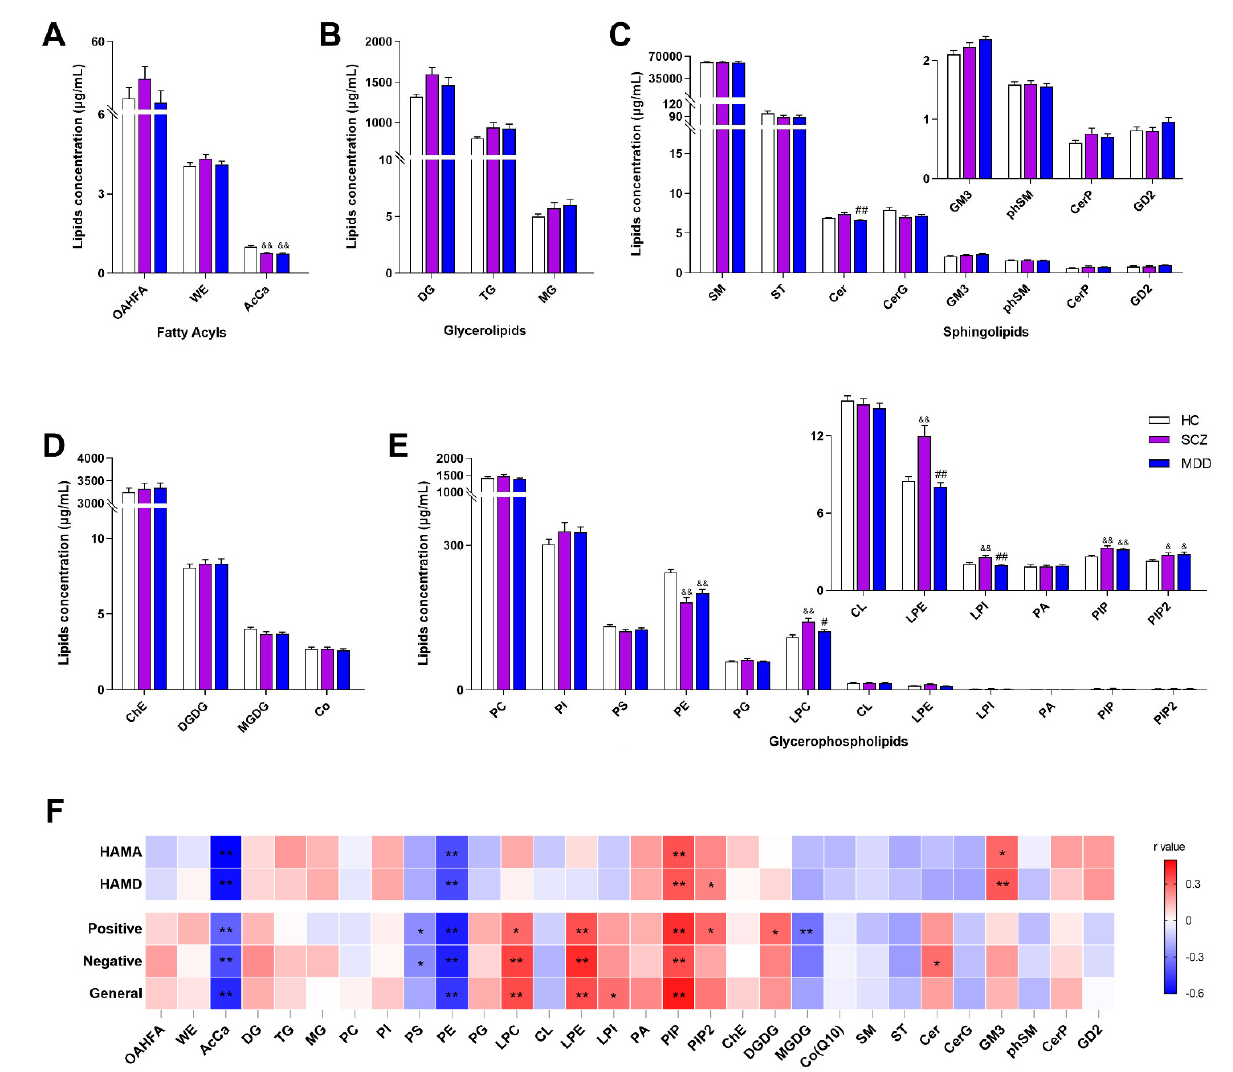
Figure 1. The comparison of lipid class among SCZ, MDD, and HC participants. ( A ) Fatty acyls, ( B ) glycerolipids, ( C ) sphingolipids, ( D ) ChE, Co, DGDG, and MGDG, ( E ) glycerophospholipids, and ( F ) correlation between clinical parameters and levels of lipid classes. AcCa, acylcarnitine; Cer, ceramides; CerG, glucosylceramides; CerP, ceramide phosphate; ChE, cholesterol ester; Co, coenzyme; CL, cardiolipin; DG, diglyceride; DGDG, digalactosyldiacylglycerol; LPC, lysophosphatidylcholine; LPE, lysophosphatidylethanolamine; LPI, lysophosphatidylinositol; MG, monoglyceride; MGDG, monogalactosyldiacylglycerol; OAHFA, (O-acyl)-1-hydroxy fatty acid; PA, phosphatidic acid; PC, phosphatidylcholine; PE, phosphatidylethanolamine; PG, phosphatidylglycerol; PI, phosphatidylinositol; PIP, phosphatidylinositol; PIP2, phosphatidylinositol 4,5-bisphosphate; PS, phosphatidylserine; phSM, phytosphingomyelin; SM, sphingomyelin; ST, sulfatide; TG, triglyceride; WE, wax esters. HC, healthy control; SCZ, schizophrenia; MDD, major depressive disorder; & p < 0.05 vs. HC, && p < 0.01 vs. HC, # p < 0.01 vs. SCZ, ## p < 0.01 vs. SCZ. Blue squares show a negative correlation and red squares show a positive correlation, * p < 0.05; ** p < 0.01.